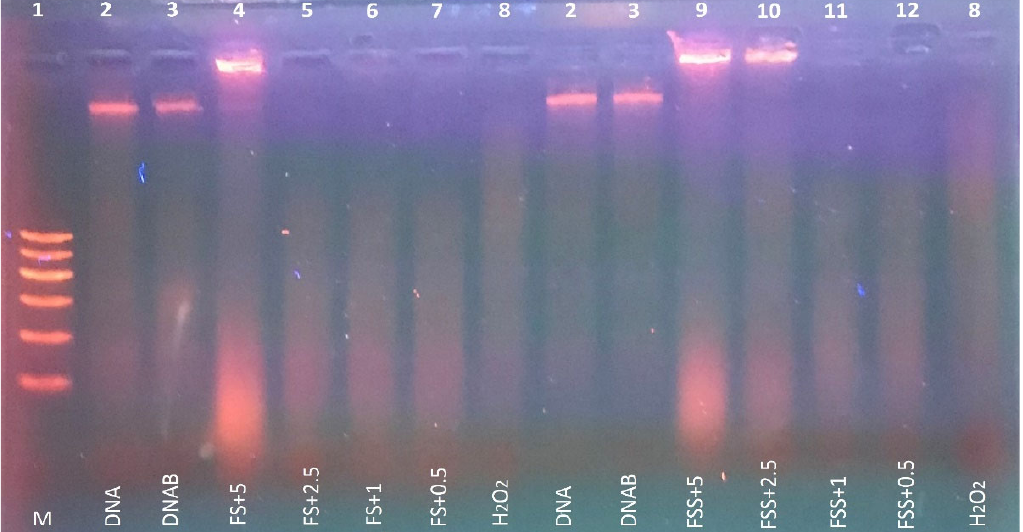
Figure 3. Protective effect of FS and FSS extracts at 2.5–5 mg mL − 1 concentrations against H 2 O 2 ‐ induced DNA oxidative damage in rat liver. Lane 1 (M): DNA marker, lane 2 (DNA): 0.5 μ g rat liver DNA, lane 3 (DNAB): 0.5 μ g rat liver DNA + 50 mM phosphate buffer, lane 4 (FS + 5): 0.5 μ g DNA